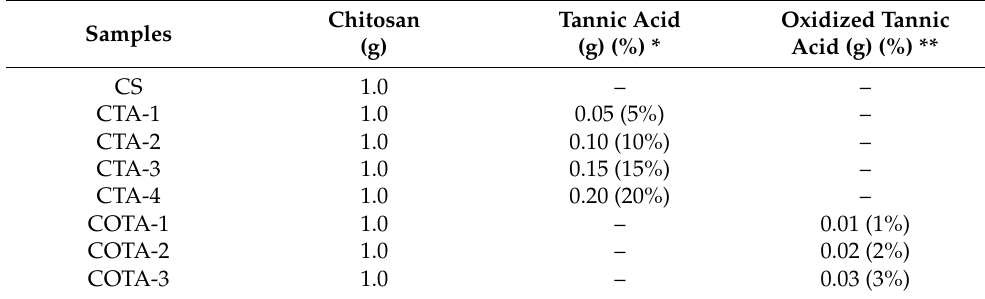
Table 6. The composition ratios of the composite